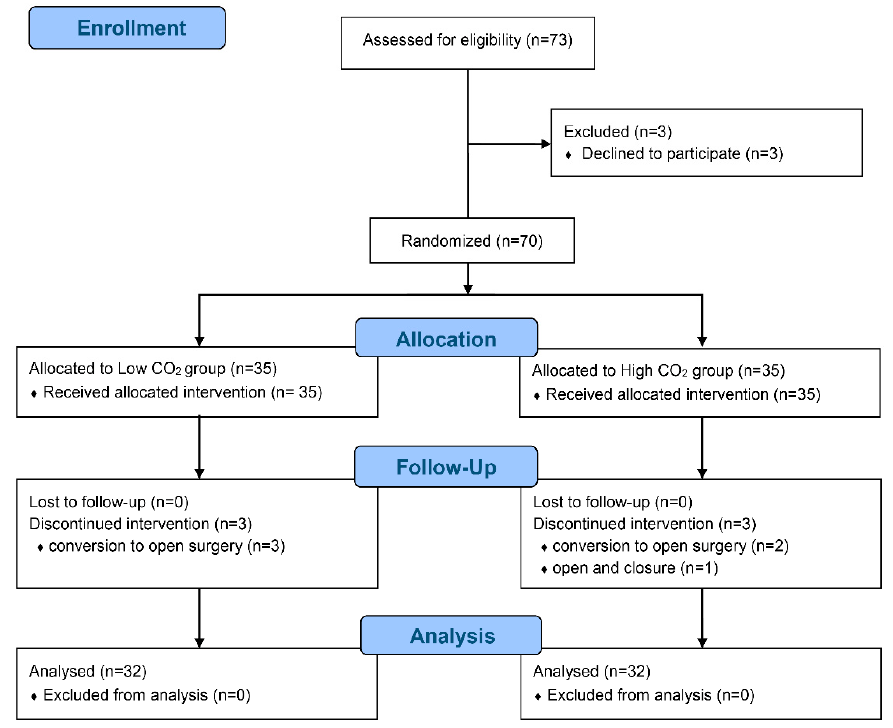
Figure 1. CONSORT flow diagram.